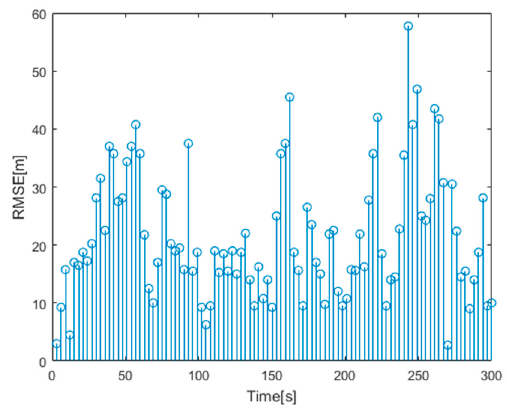
Sensors 2020 , 18 , x FOR PEER REVIEW 16 of 19 Figure 10. Target 1 radar dwell time allocation ratio. Figure 10. Target 1 radar dwell time allocation ratio.